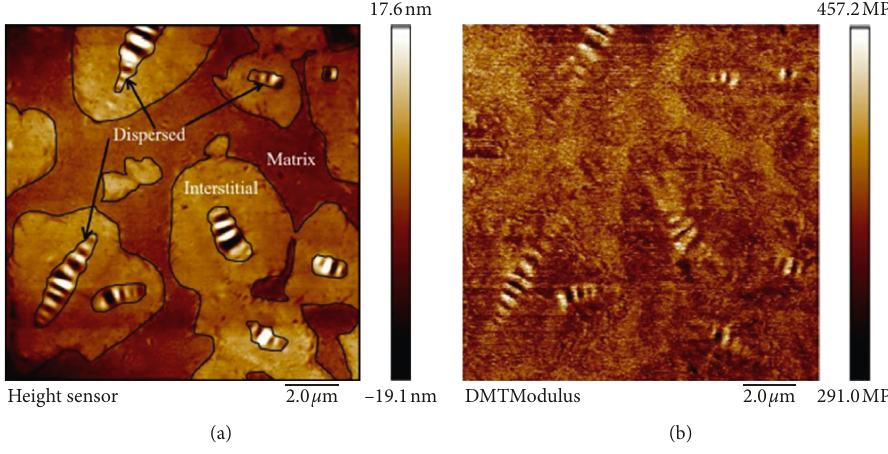
Figure 27: (a) Micrographs of asphalt phases before application of strain and (b) after